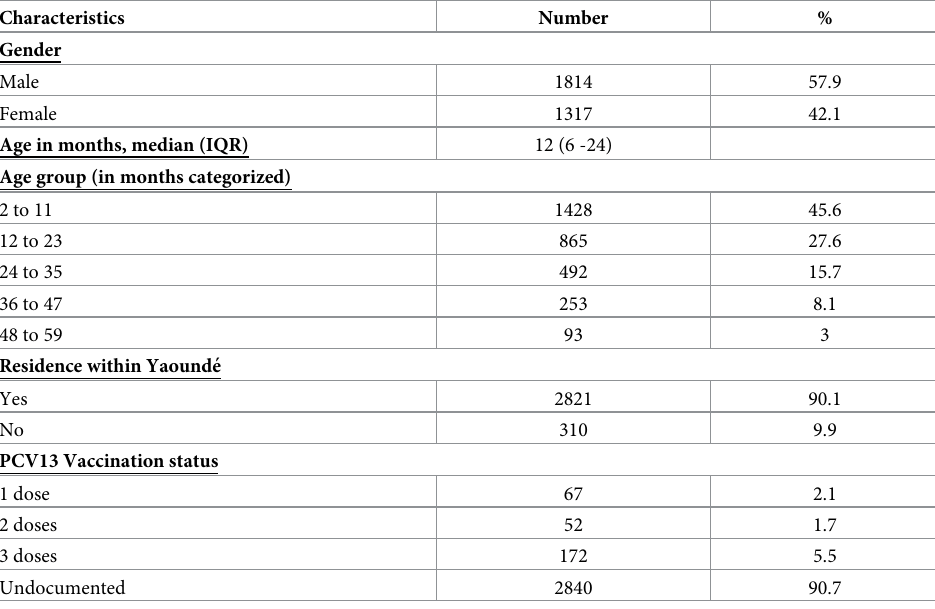
Table 2. Demographics and vaccination status of children aged 2 – 59 months evaluated for suspected meningitis and admitted at the sentinel surveillance hospitals in Yaounde´: 2011—2018 (N = 3131).